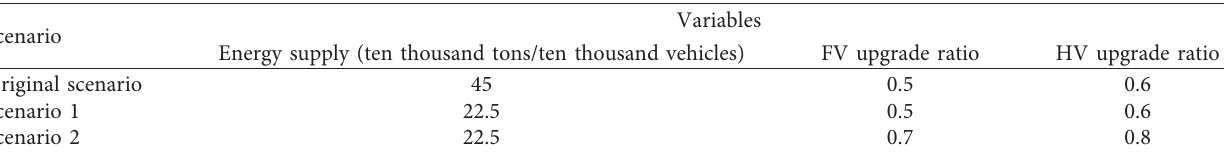
Figure 3: Test function and the number of different types of vehicles. (a) Listing rate; (b) number of FVs, HVs, and EVs. Table 1: Design of energy supply and vehicle upgrade ratio under three